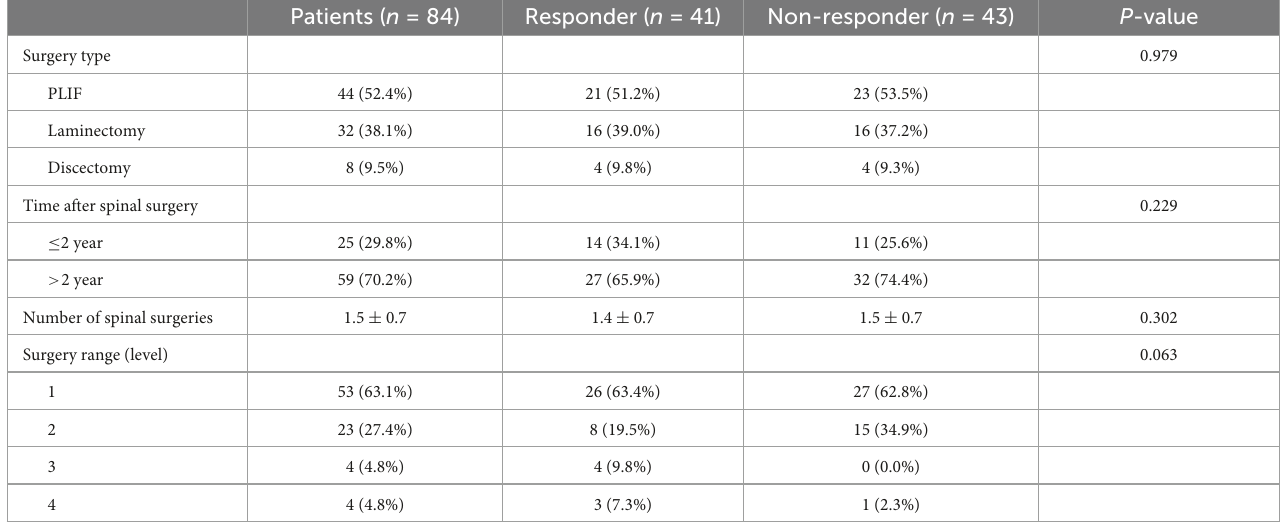
TABLE 2 Surgical characteristics of patients.